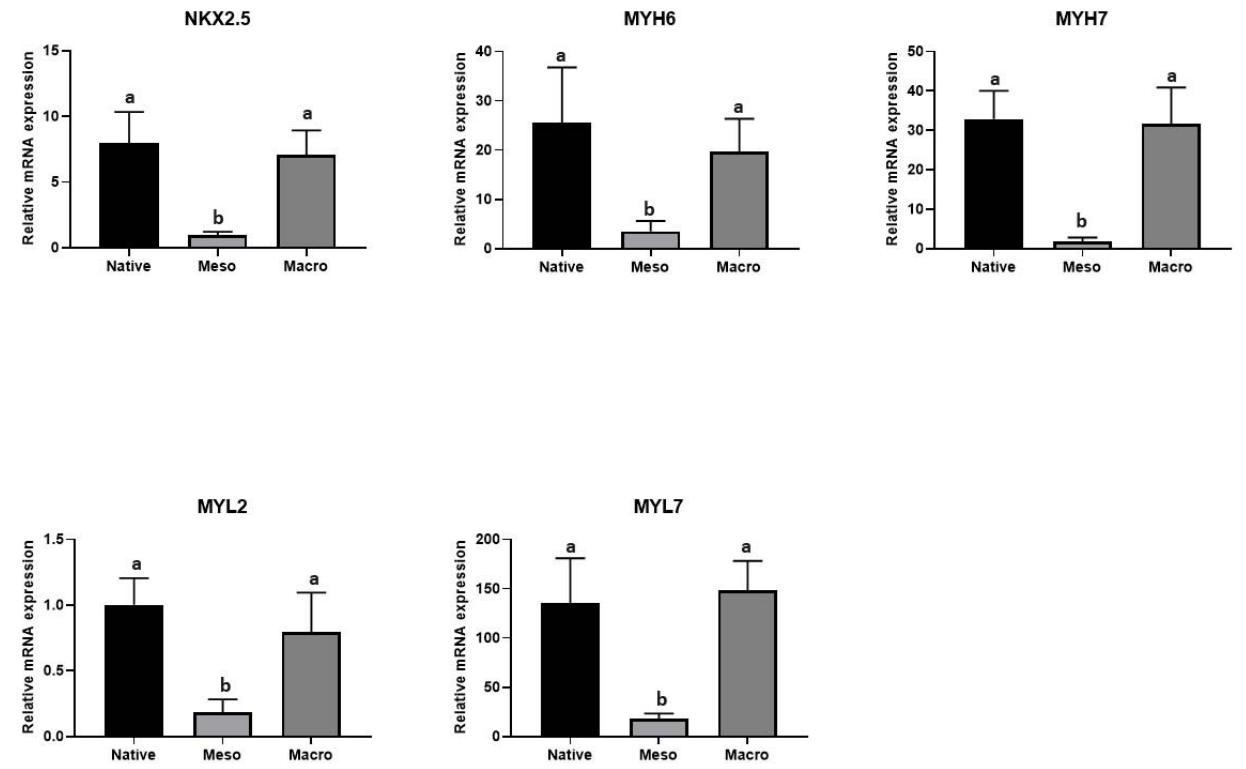
Figure 5. The expressions of markers of cardiomyogenesis detected by qRT PCR. The different superscripts (a/b) express significant differences ( p ≤ 0.05).